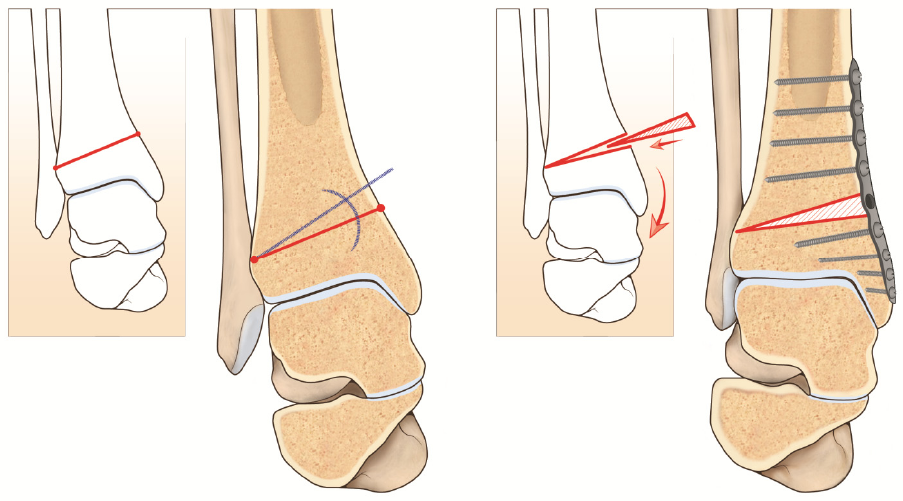
Figure 4. Visual artwork showing supramalleolar osteotomy in varus ankle deformity.